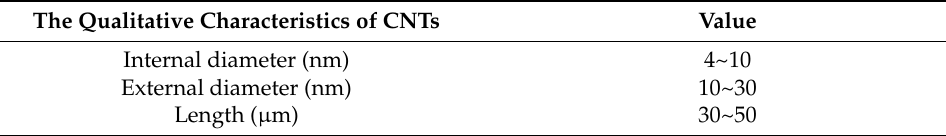
Table 1. Properties of